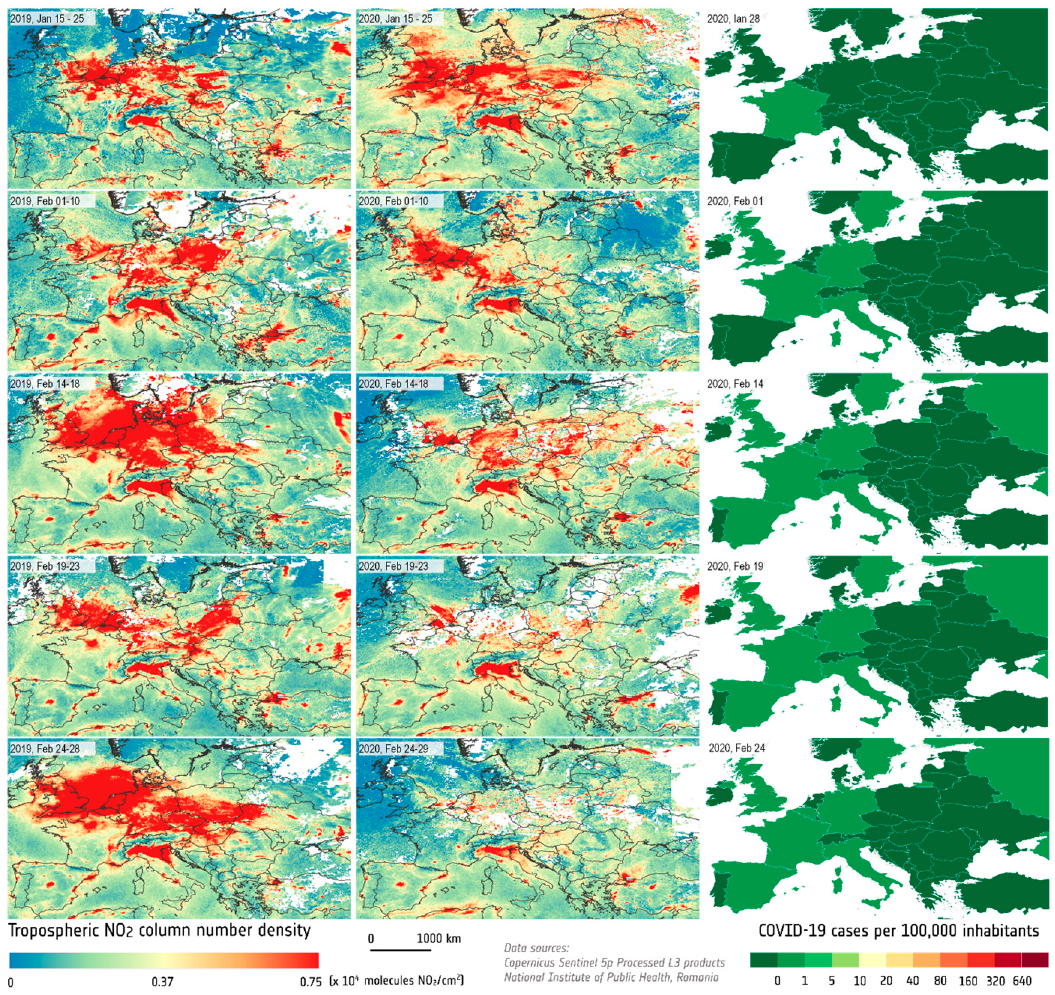
Figure 1. Comparative cartographic representations of the 10- or 5-day average tropospheric NO 2 column number density over Europe between mid-January to end of February in 2019 and 2020, and the incidence rate of COVID-19 confirmed cases in European countries.